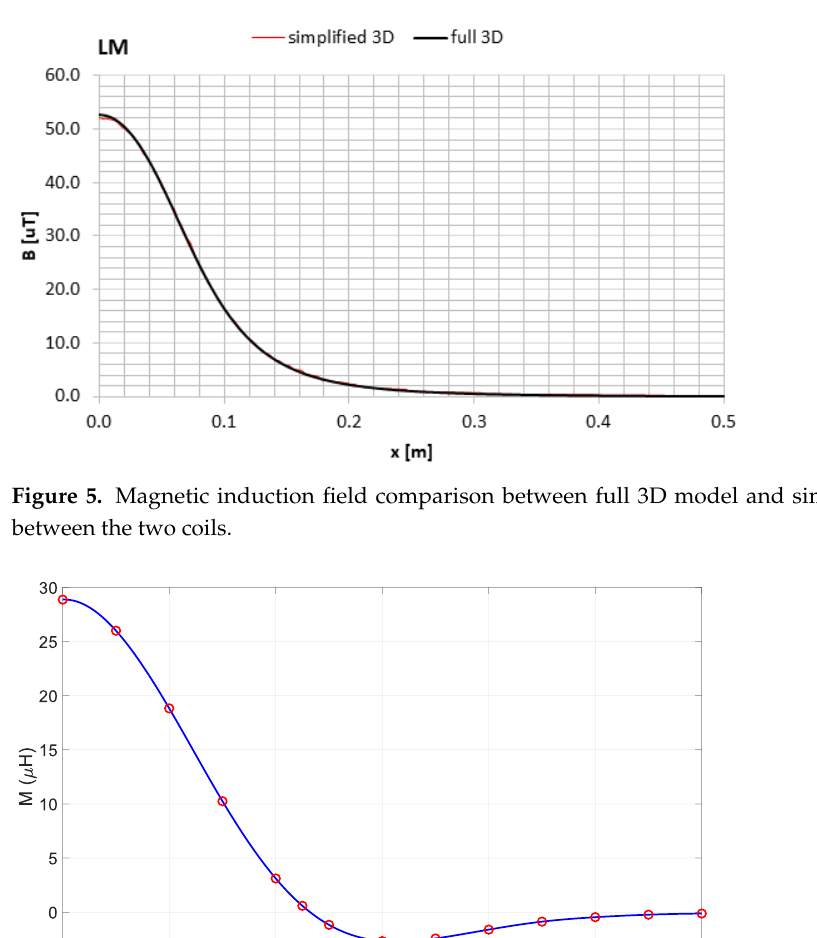
Table 2. self and mutual-inductance for different positions.